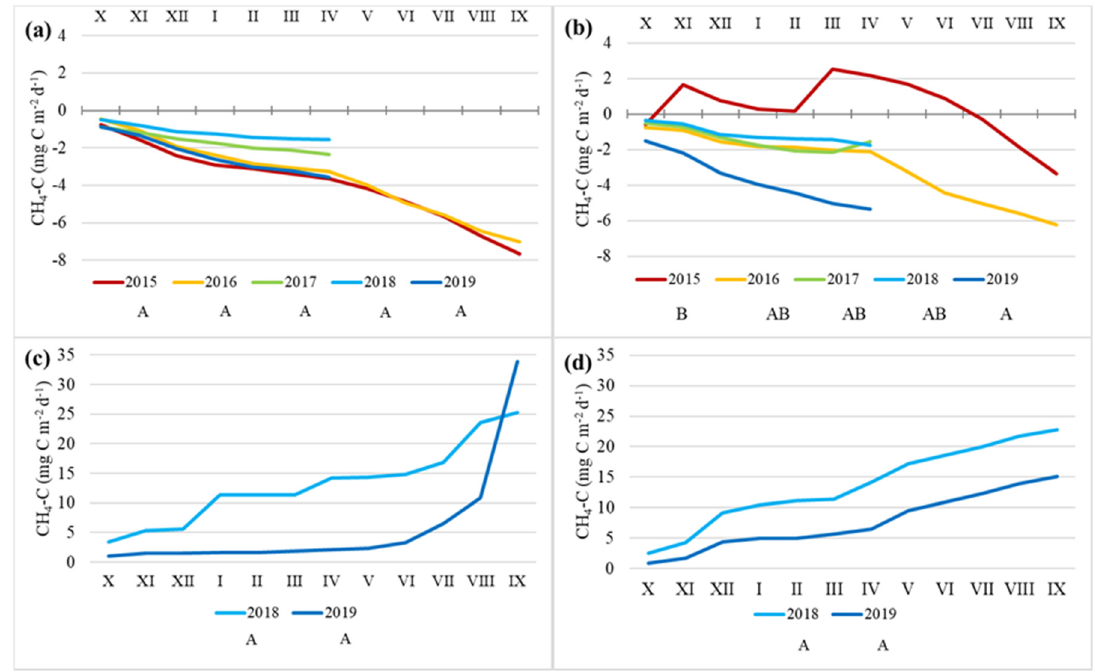
Figure 7. Cumulative annual CH 4 -C emissions at Norway spruce ( a ) and Downy birch ( b ) drained peatland forests and Ess-soo ( c ) and Laiuse ( d ) abandoned peat extraction areas. X (October) to IX (September)—months. Capital letters A, AB and B indicate significantly differing values (Kruskal–Wallis ANOVA test and multiple comparison of mean ranks test).